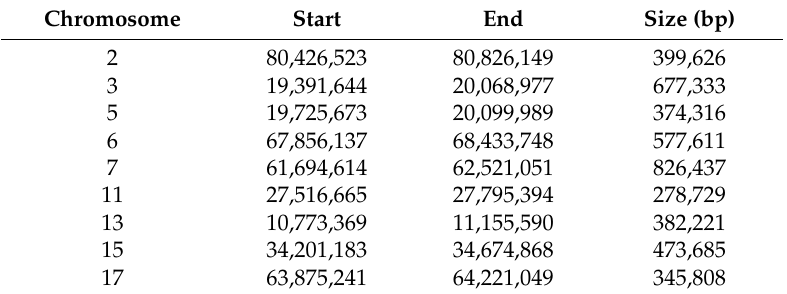
Figure 4. Genome-wide distribution of diversifying selection signatures among Sok ó lski and Sztumski horses, ( A ) detected with sliding-window approach and ( B ) BayeScan software. In part A, sliding window-averaged F ST values for individual SNPs are plotted against centered genomic positions of the windows. Dashed line shows threshold for the top 0.1% highest F ST values (0.085). In part B, − log10 p -values are plotted. Dashed line indicates SNPs with p -value < 0.05. Table 2. Genomic regions with the strongest diversifying selection signatures among the analyzed populations according to the sliding-window based